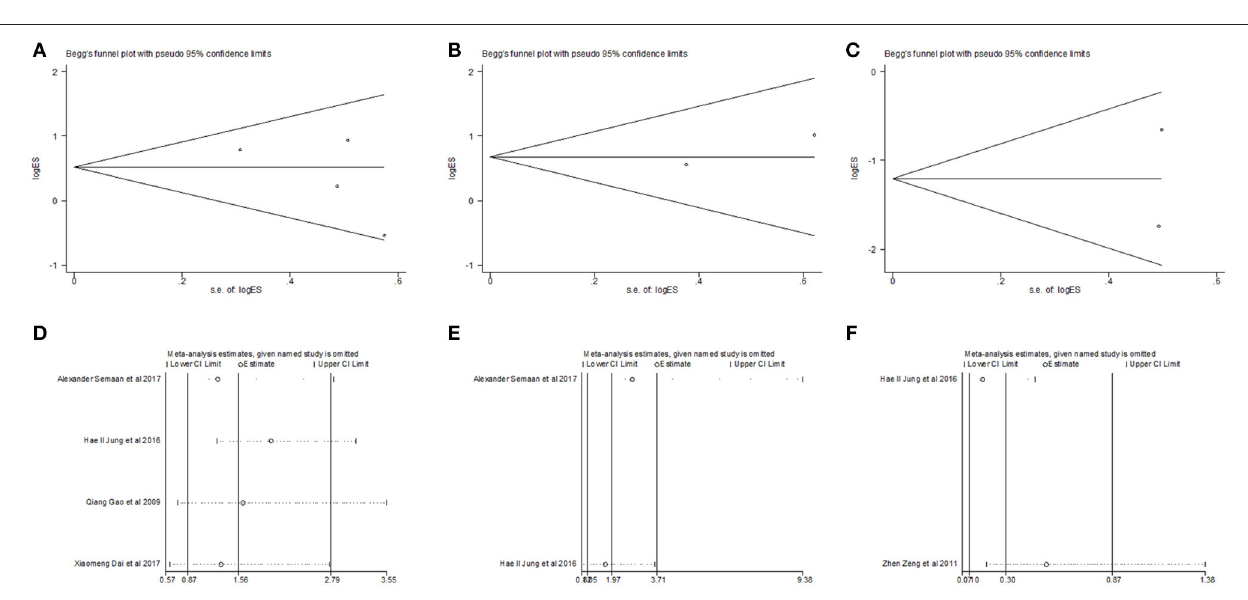
FIGURE 5 | Begg’s funnel plot for publication bias tests in (A) liver cirrhosis, (B) portal vein invasion and (C) BCLC stage. Sensitivity analysis in (D) liver cirrhosis, (E) portal vein invasion and (F) BCLC